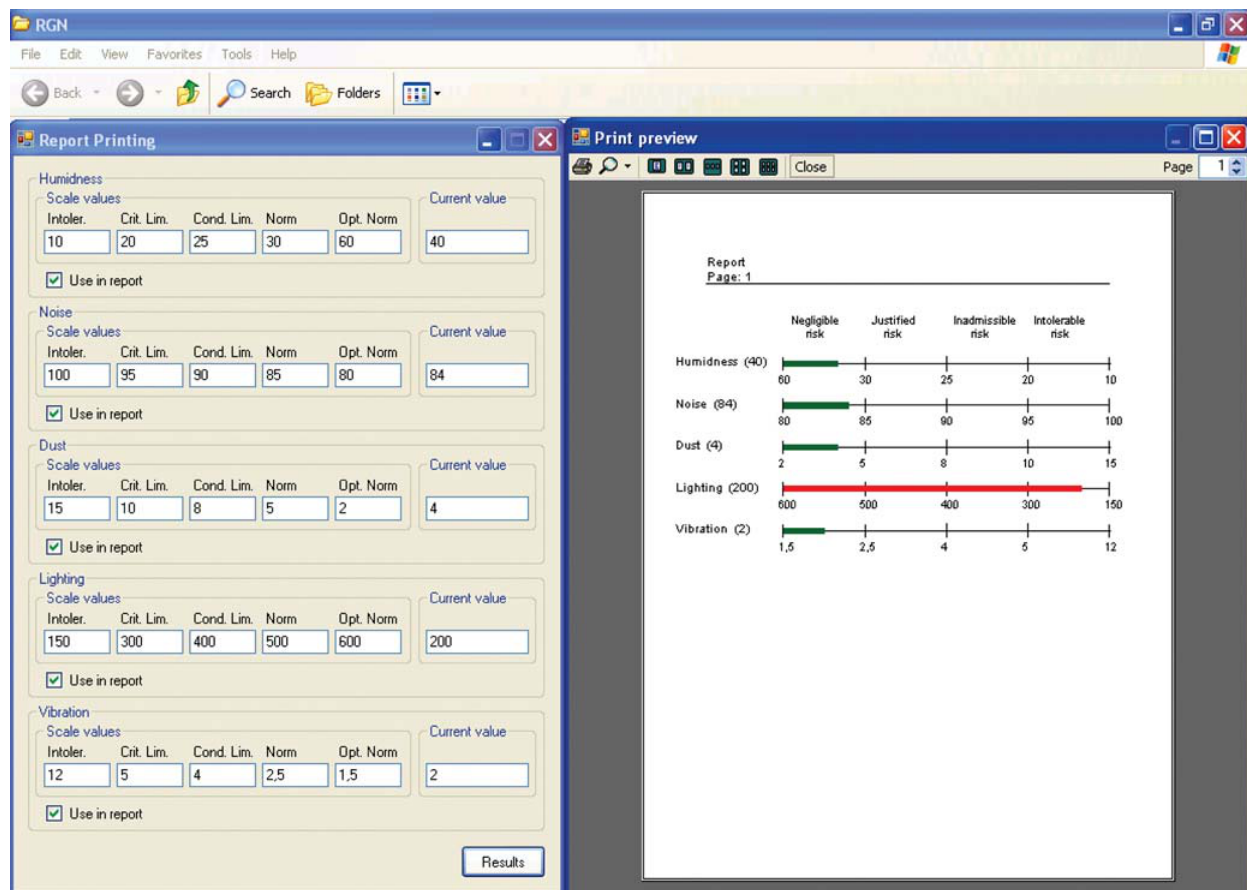
Fig. 2 . The computerized method for risk assessment at workplace